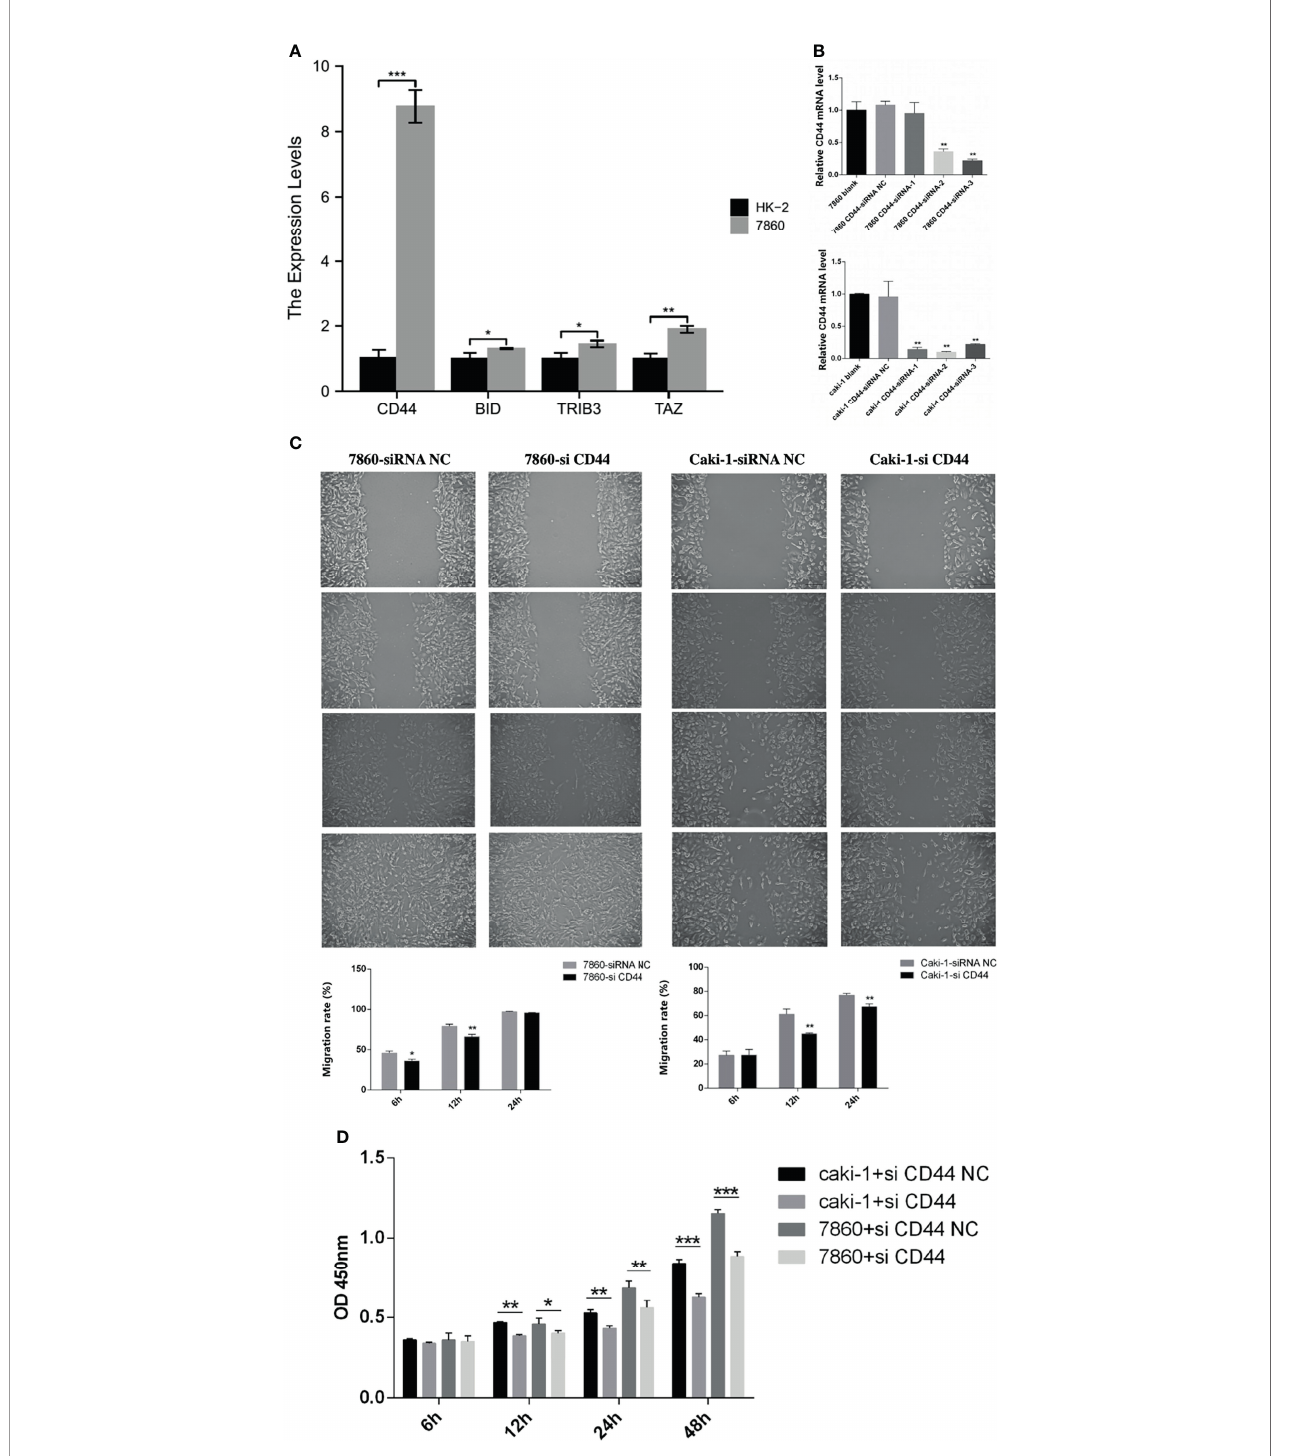
FIGURE 14 | Experimental veri fi cation processes. (A) The histogram showed the relative expression levels of the 4 FRGs evaluated by RT-qPCR in the HK-2 cells and the 7860 cells. (B) Using RT-qPCR to evaluate the ef fi ciency of gene knockdown by siRNA in the 7860 cells and the Caki-1 cells. (C) Scratch assay results showed the migration rate of the siRNA-CD44 cells and the siRNA-NC cells. (D) CCK-8 assay results showed the relative proliferation the siRNA-CD44 cells and the siRNA-NC cells. All experiments were repeated at least three times, and the data were shown as means ± S.D. *P < 0.05, **P < 0.01, ***P <